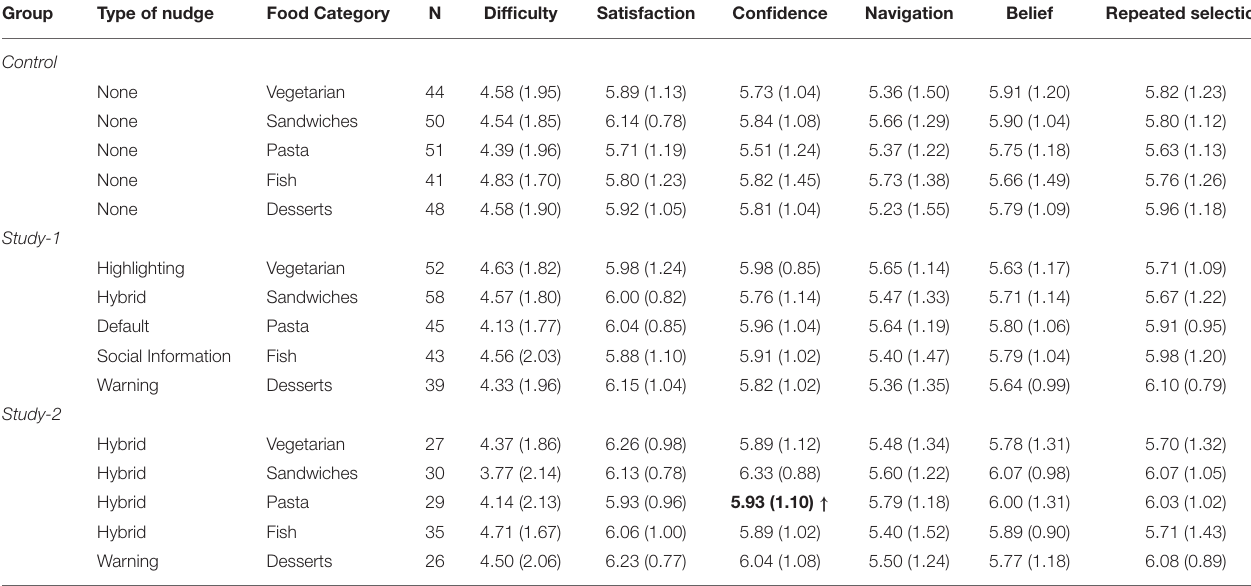
Table A2 | Mean answer given in the questionnaire after each decision split by type of nudge and food